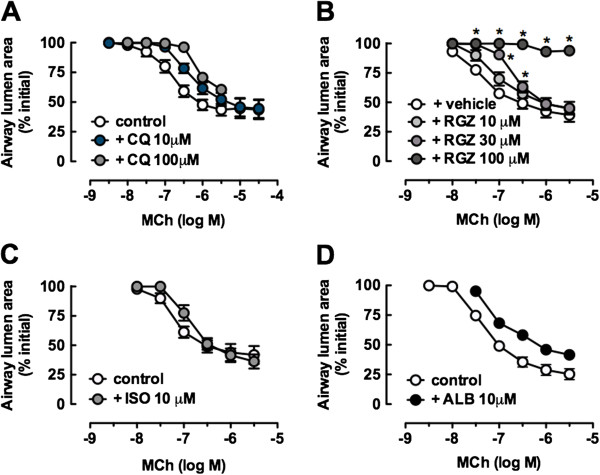
Rosiglitazone, but not chloroquine, isoproterenol or albuterol, inhibits the initiation and development of methacholine-induced contraction. Lung slices were perfused with increasing concentrations of methacholine (MCh) in the presence of A) chloroquine (CQ) (control: n = 8, 10 μM: n = 8, 100 μM: n = 3), B) rosiglitazone (RGZ) (vehicle: n = 4, 10 μM: n = 3, 30 μM: n = 4, 100 μM: n = 4), C) isoproterenol (ISO) (control: n = 4, 10 μM: n = 4) or D) albuterol (ALB) (control n = 4, 10 μM, n = 4). Responses (mean ± S.E.M) represent the airway lumen area (normalized to the initial area), averaged over the last minute of perfusion at each MCh concentration. *p < 0.05, 2 way ANOVA, Bonferroni post-hoc.